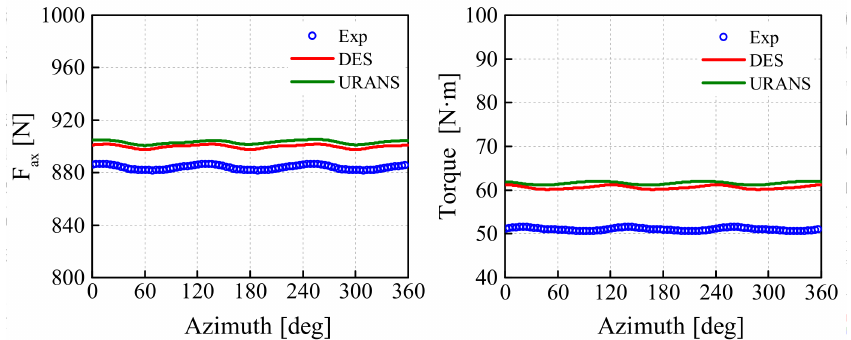
Figure 5. Comparison of the rotor axial force and torque at the wind speed of 10 m/s, TSR = 10.